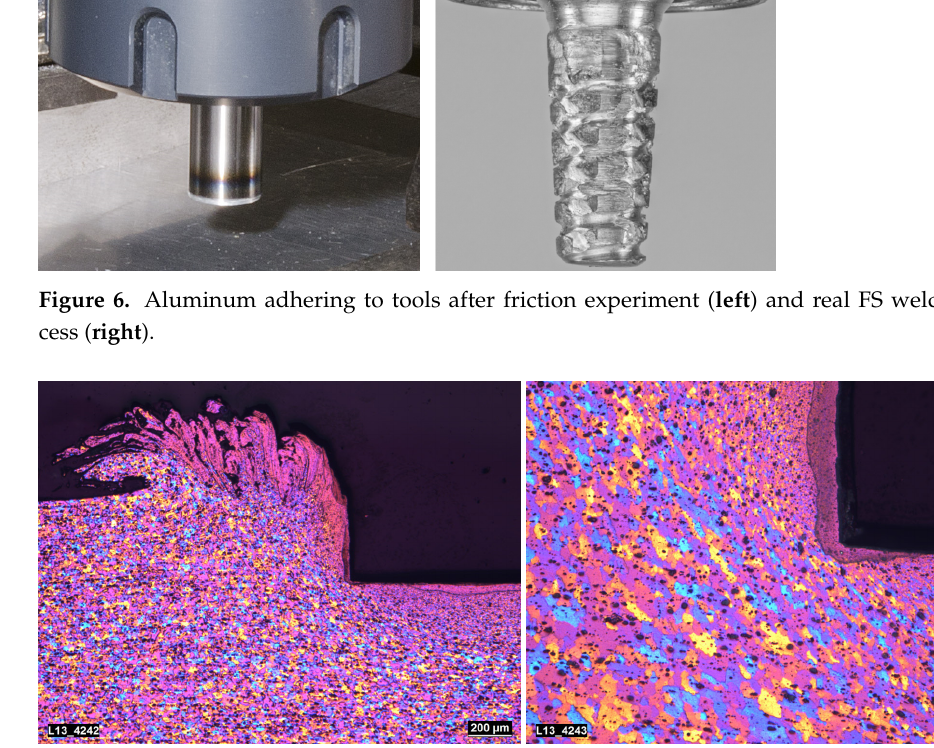
Figure 7. Cross-section of experiment R 95, showing wear-in, penetration, and continuous dynamic recrystallization. On the left: severe plastic deformation of the aluminum substrate and accumulation of oxides/former debris layers close to the